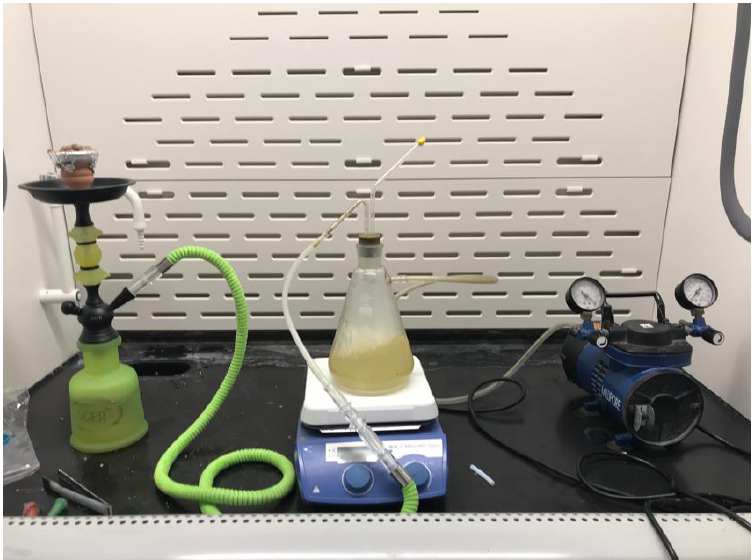
Figure 1. A new waterpipe smoking (WPS) setup used to collect smoke residue.